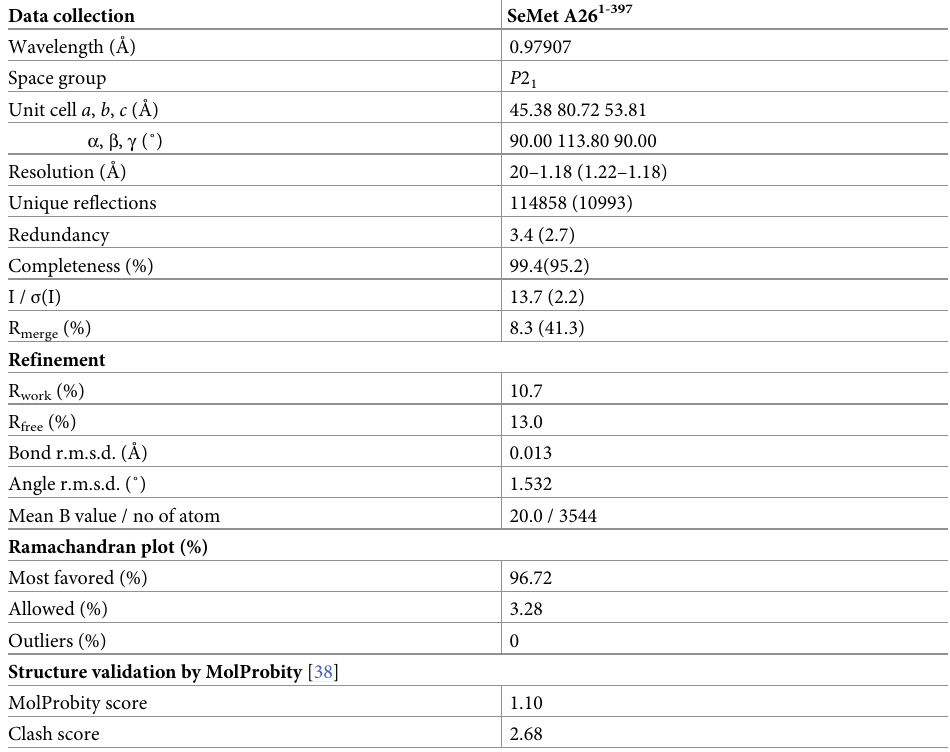
Table 2. Data collection and refinement statistics for the crystal structure of A26(1–397)